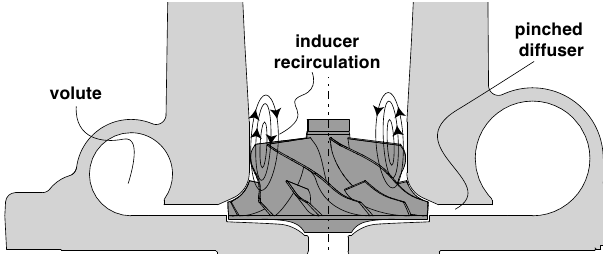
Figure 2. Compressor design and schematic visualization of inducer